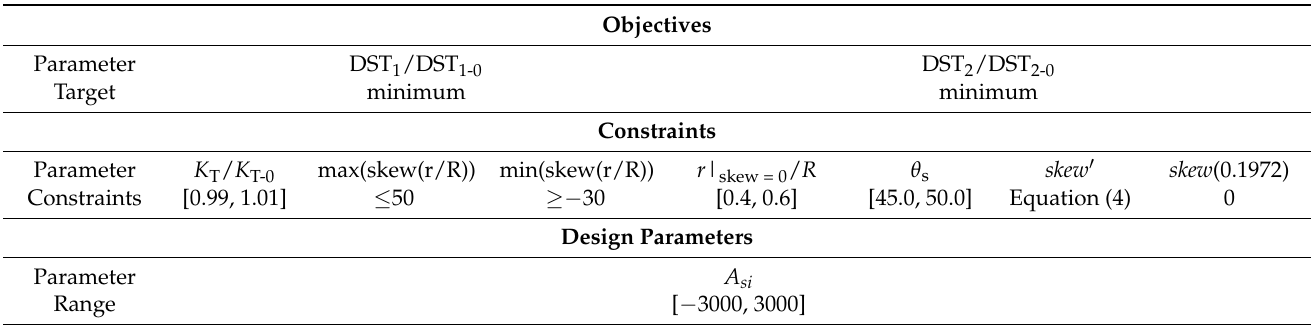
Table 3. Design parameters, constraints and objectives of